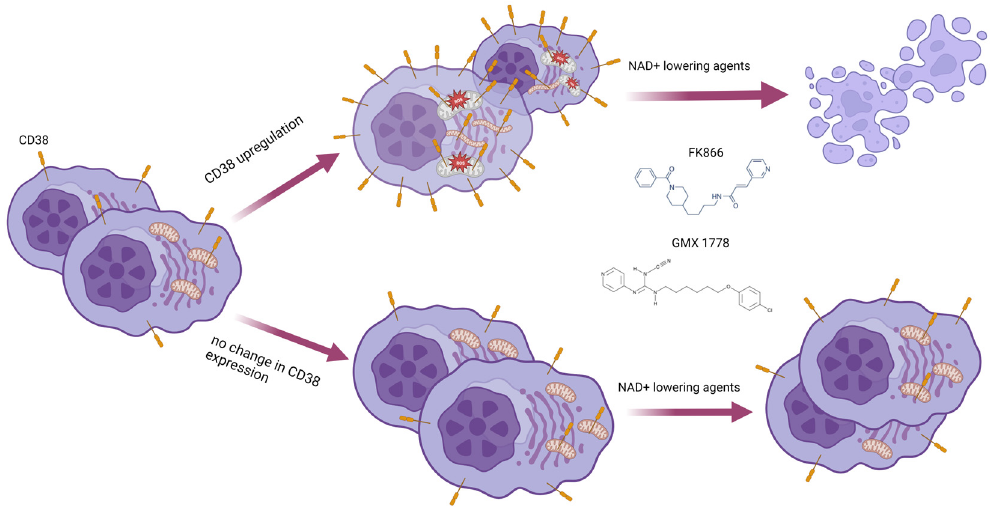
Figure 10. Graphic of proposed model: CD38 upregulation by genetic or pharmacologic (ATRA, LEN, or POM) approaches result in energetic remodeling with mitochondria dynamic shifts and oxidative stress priming MM cells for low doses of NAD+-depleting agents.